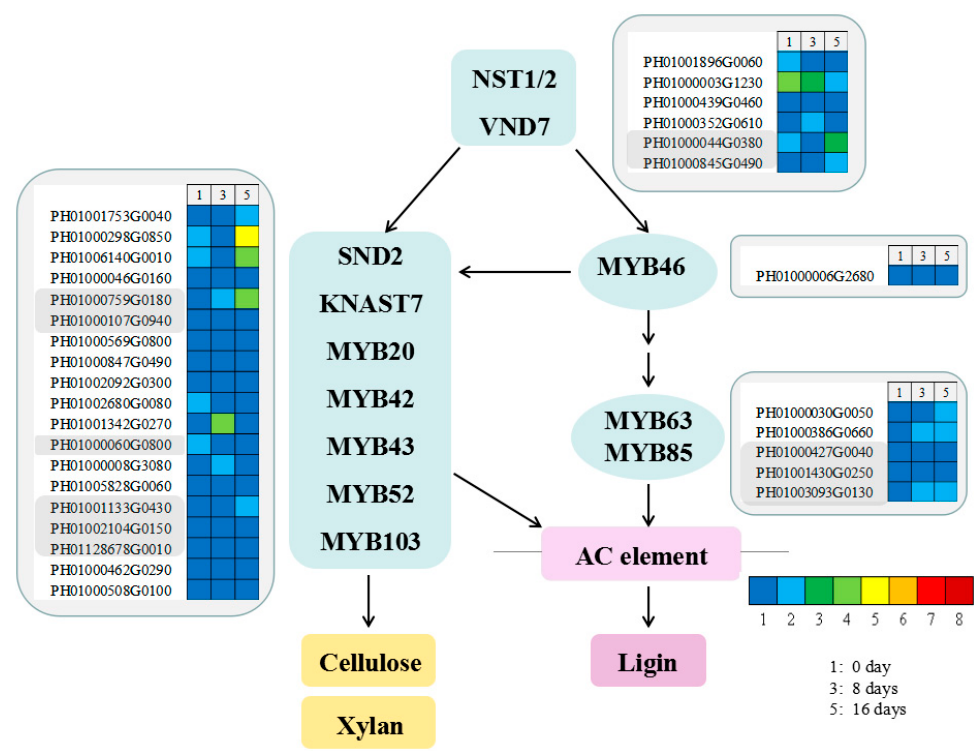
Figure 8. Unigenes in the transcriptional network regulating secondary cell wall biosynthesis and lignification according to Arabidopsis thaliana . Enzyme names, unigene IDs, and expression patterns are indicated in each step. The grids with eight different colors from blue to red show the RPKM values. Here, 0-0.01, 0.01-0.05, 0.1-0.5, 0.5-1, 1-3, 3-5, 10-15, and over 15 are represented by colors 1 to 8, respectively.